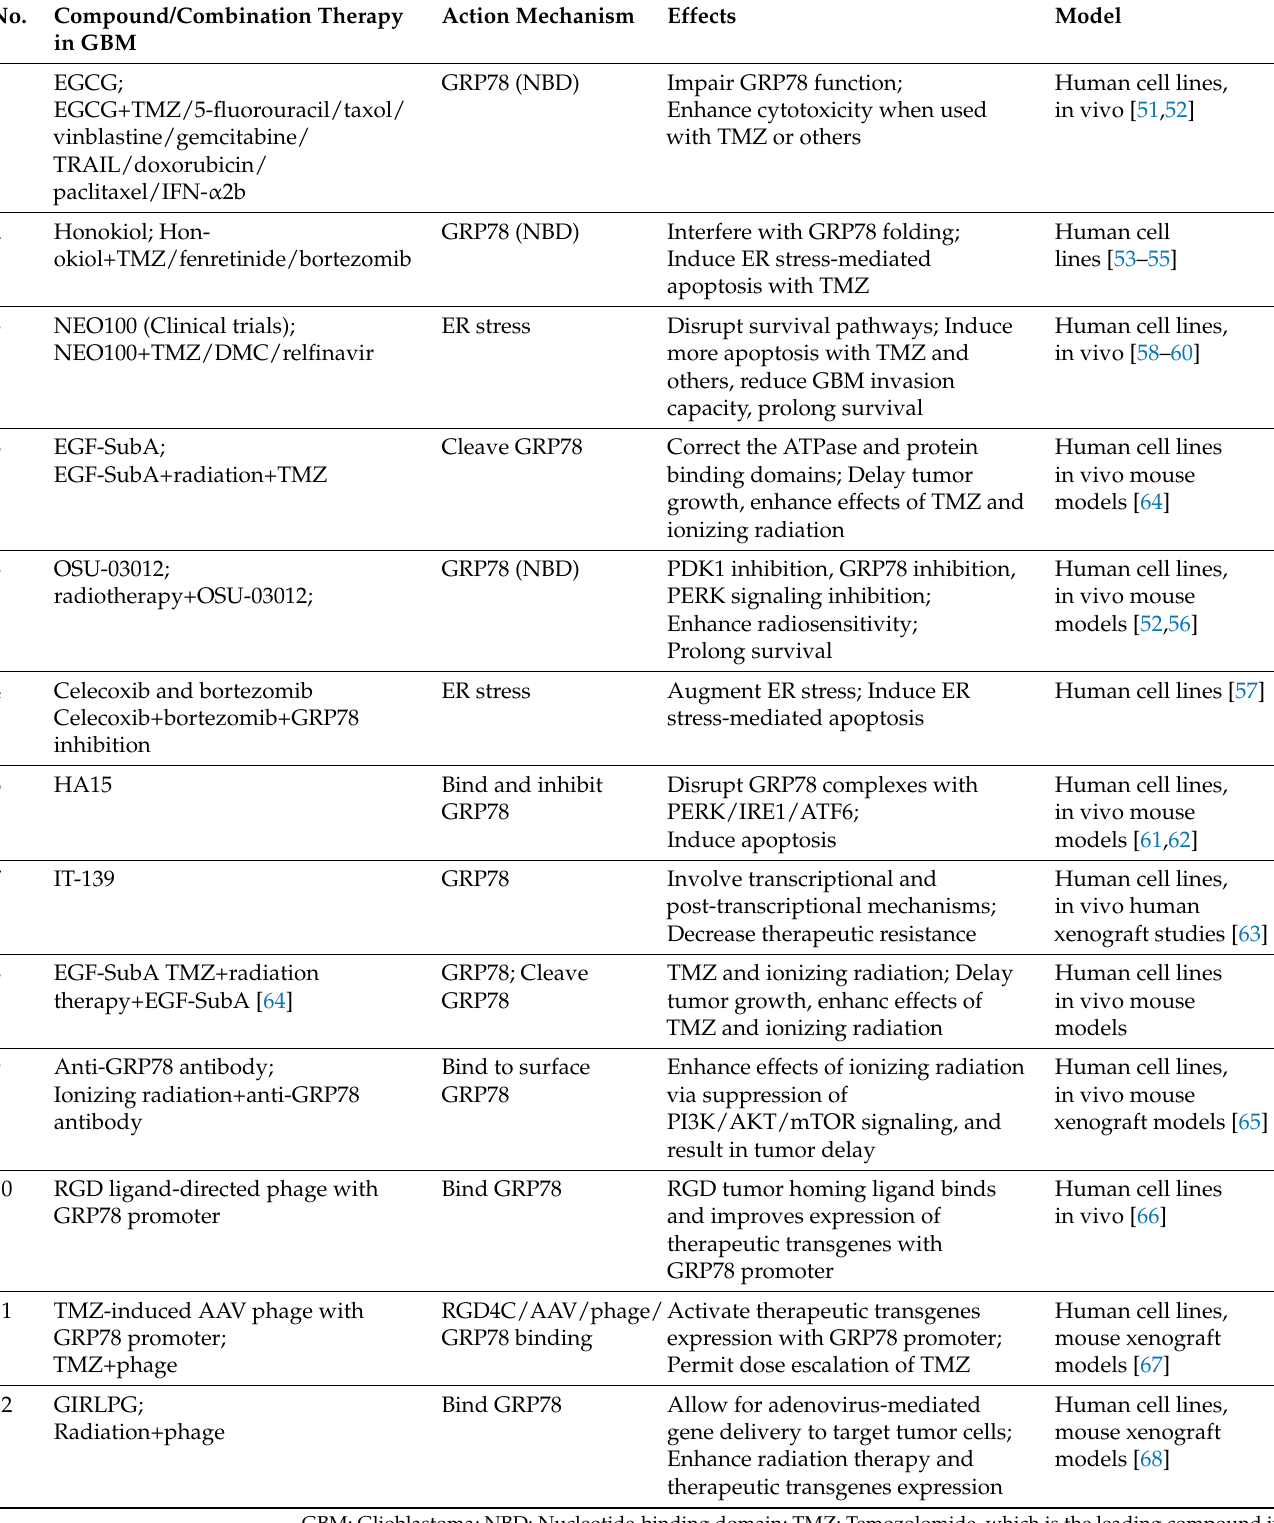
Table 2. GRP78 inhibitors and inducers and their action mechanisms and effects